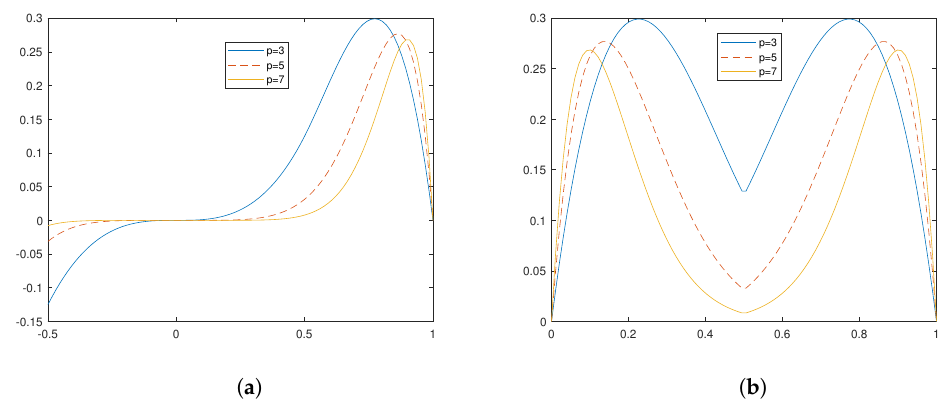
with different values NR